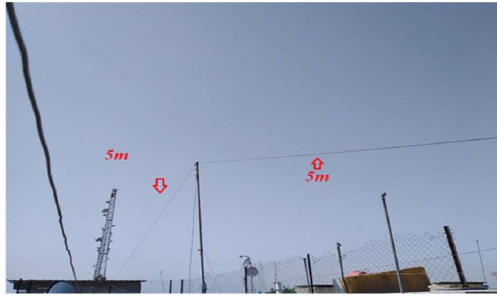
Fig. 16. Shows dipole antenna of 10m long,8m height above groundTable 1 shows HF circuit points geographical locations.